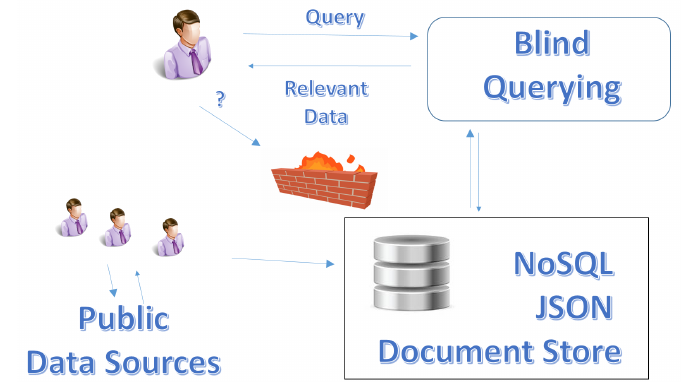
Figure 1. Application Scenario of the HammerJDB